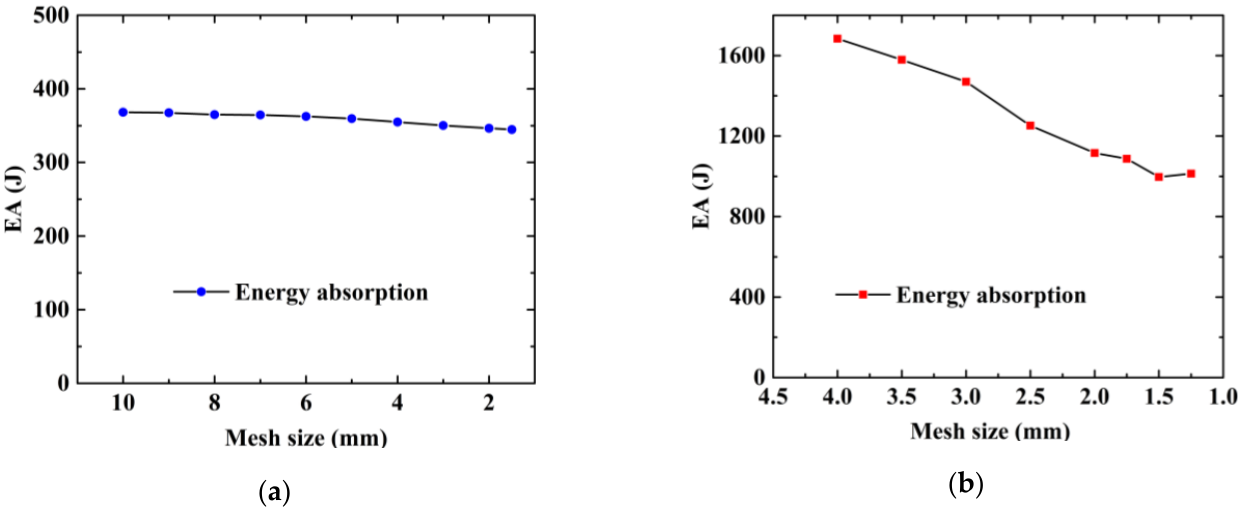
Figure 11. Mesh convergence study: ( a ) aluminum foam and ( b ) local nanocrystallized tube.